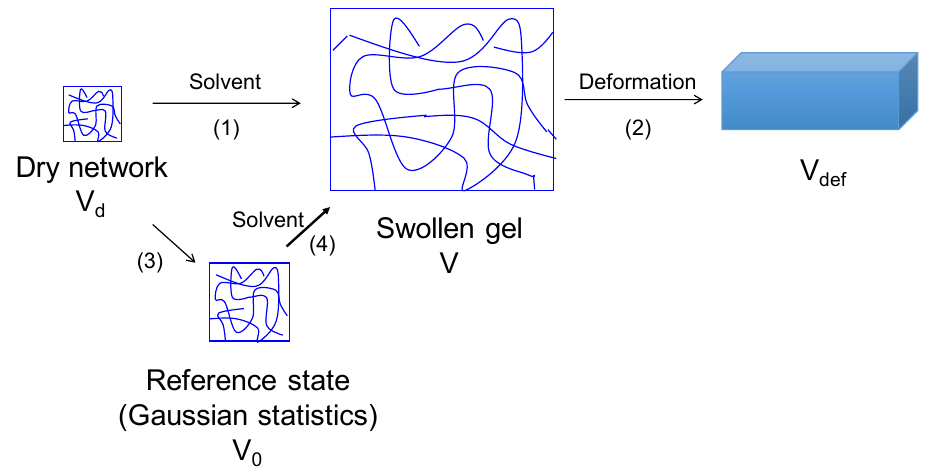
Figure 1. Gel behavior: (1) swelling of a gel from its dry state to its final equilibrated swollen state. (2) Deformation of an equilibrated gel due to externally imposed forces. In theoretical models, step (1) is taken as the sum of steps (3) and (4) by invoking a hypothetical reference state where the chains are assumed to obey Gaussian chain